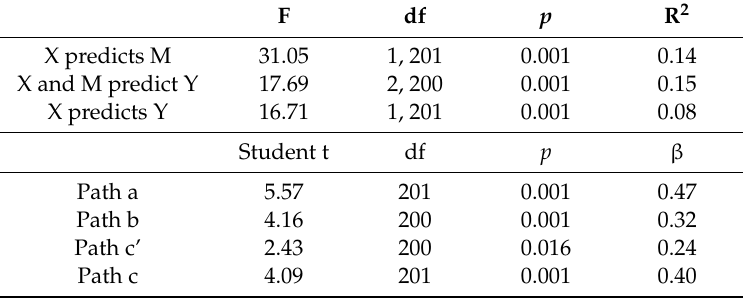
Figure 1. Model 1. Relationship between connectedness to nature and the WAMI, with ISC as a mediator. Mediator Effect Size = 0.11. Table 4. Model 1. Mediation analysis statistics.